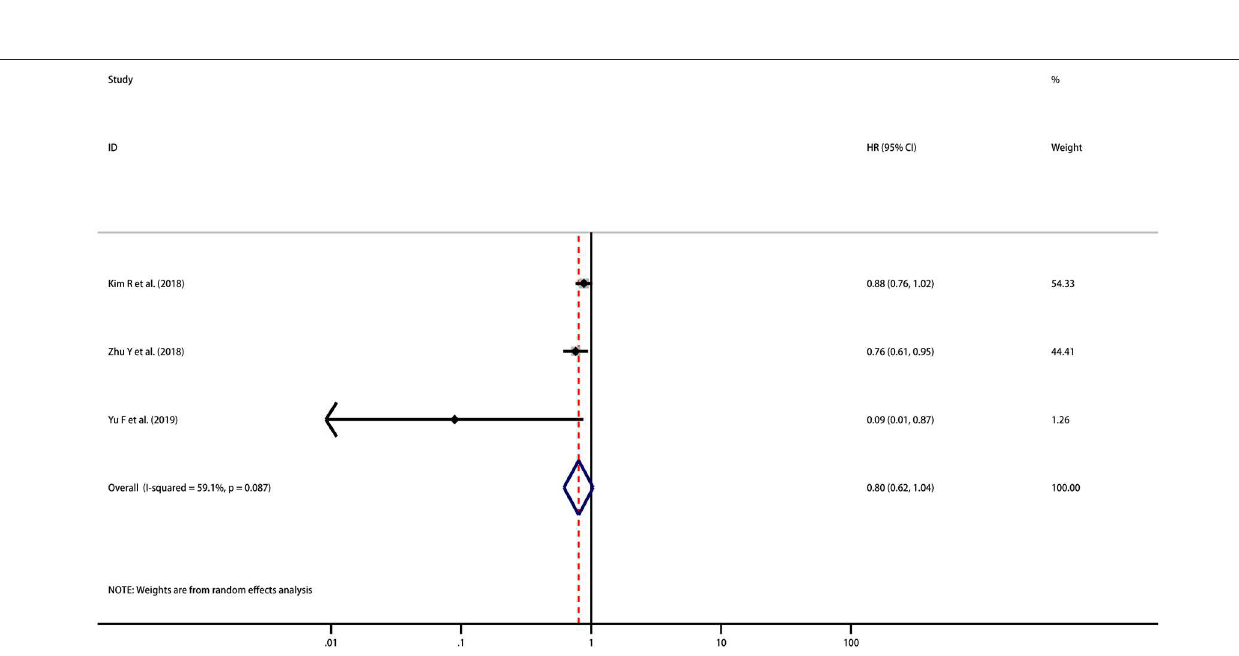
Frontiers in Oncology |